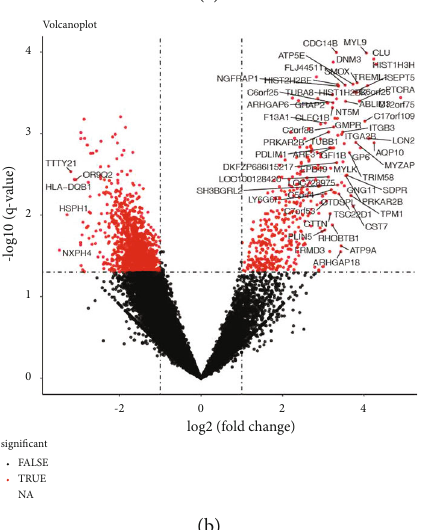
Figure 1: Identi fi cation of di ff erentially expressed genes (DEGs) between circulating tumor cells (CTCs) and normal control groups. (a) The identi fi ed DEGs displayed in heat map. (b) The identi fi ed DEGs displayed by volcano